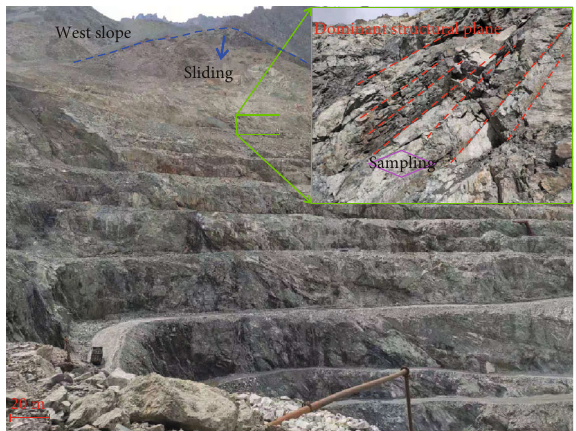
Figure 1: Result of the rock core from the west slope of Beizhan open pit slope. A set of dominant structural plane can be observed as drawn in red